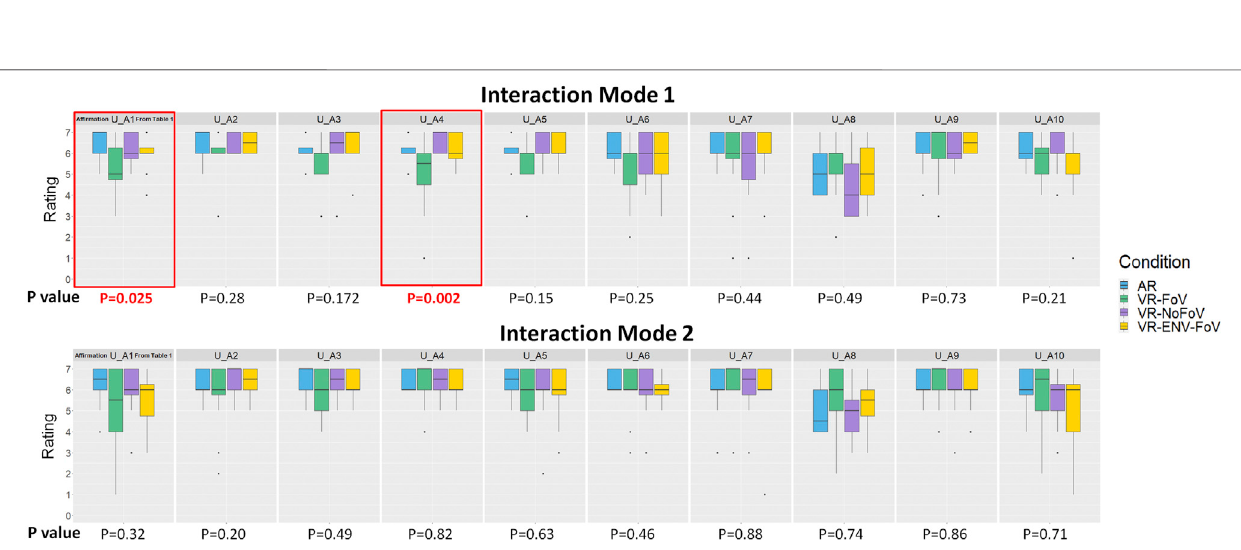
Frontiers in Virtual Reality |